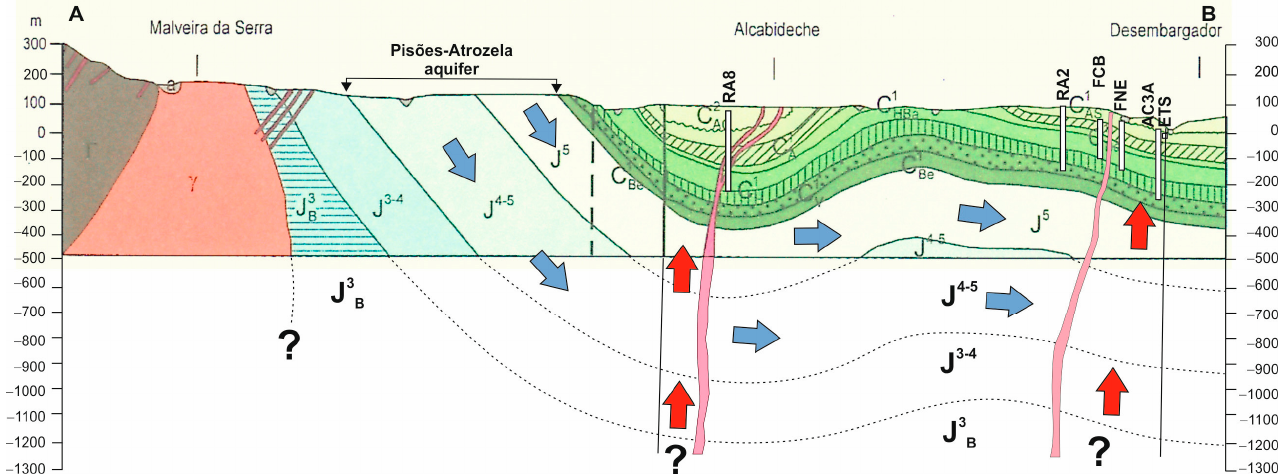
Figure 12. Conceptual model proposed after the geological cross-section of Figure 2c. Blue and red arrows represent cold and warm groundwater flowpaths, respectively.